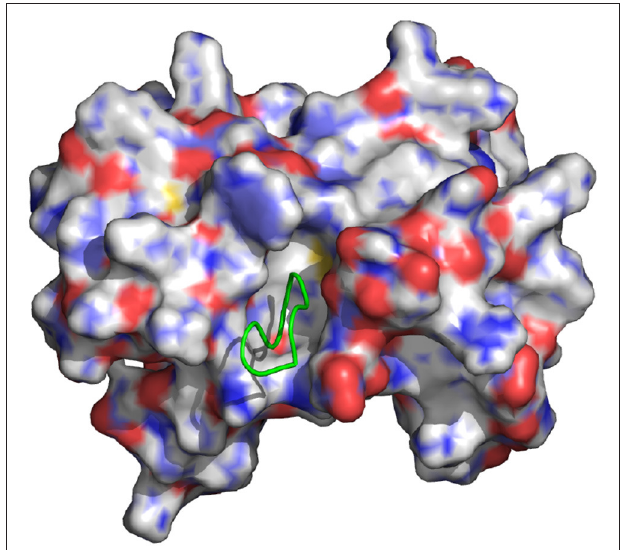
FIGURE 1 | Representation of the wild-type cyclic peptide (SLKIDNLD) bound to the LEDGF binding domain of HIV1 integrase (PDB id: 3AVB). The cyclic peptide (green) is shown in tube representation. The integrase receptor is shown in surface representation colored by electrostatic